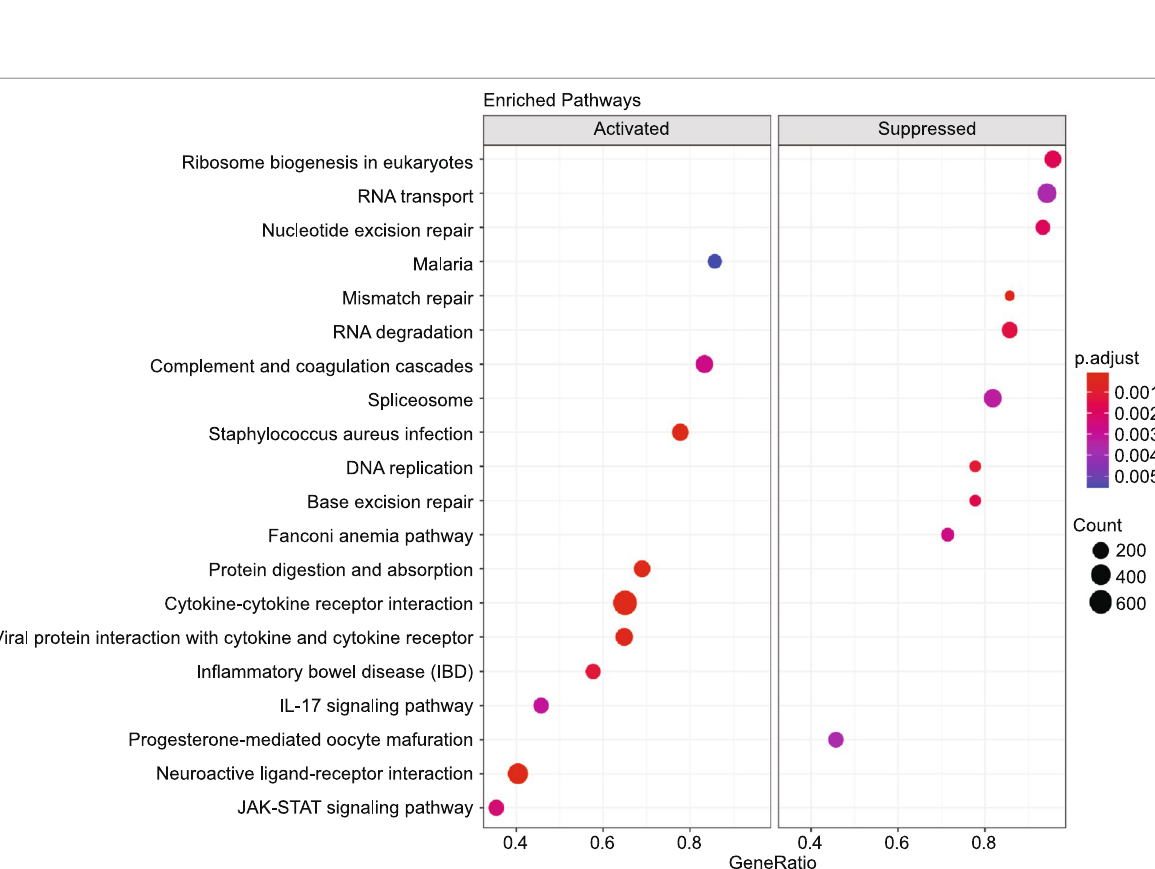
0.05). GSEA, gene set enrichment ≤